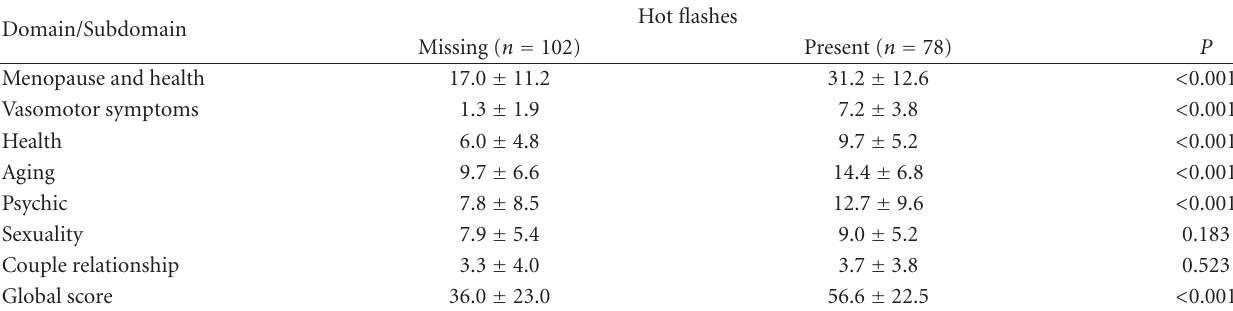
Table 5: Mean cervantes scale scores in brazilian women with or without hot